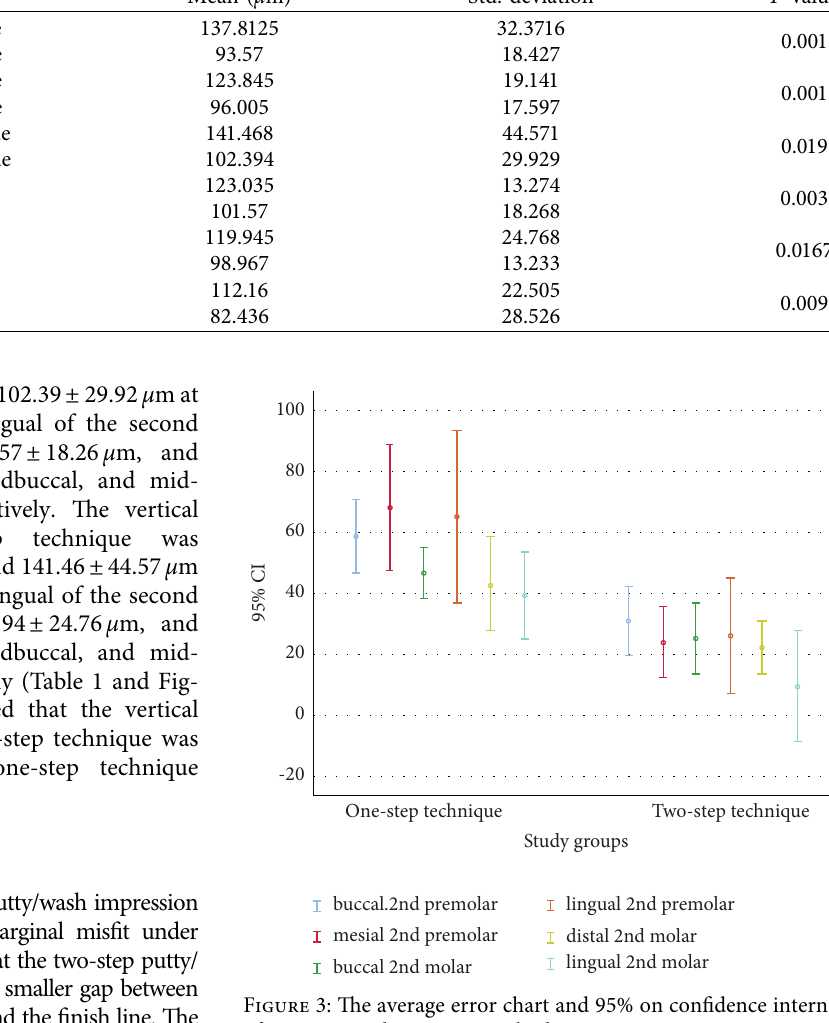
Table 1: Te independent t -test results of the vertical marginal misft comparing each surface between one-step and two-step techniques. Group Mean ( μ m) Std. deviation